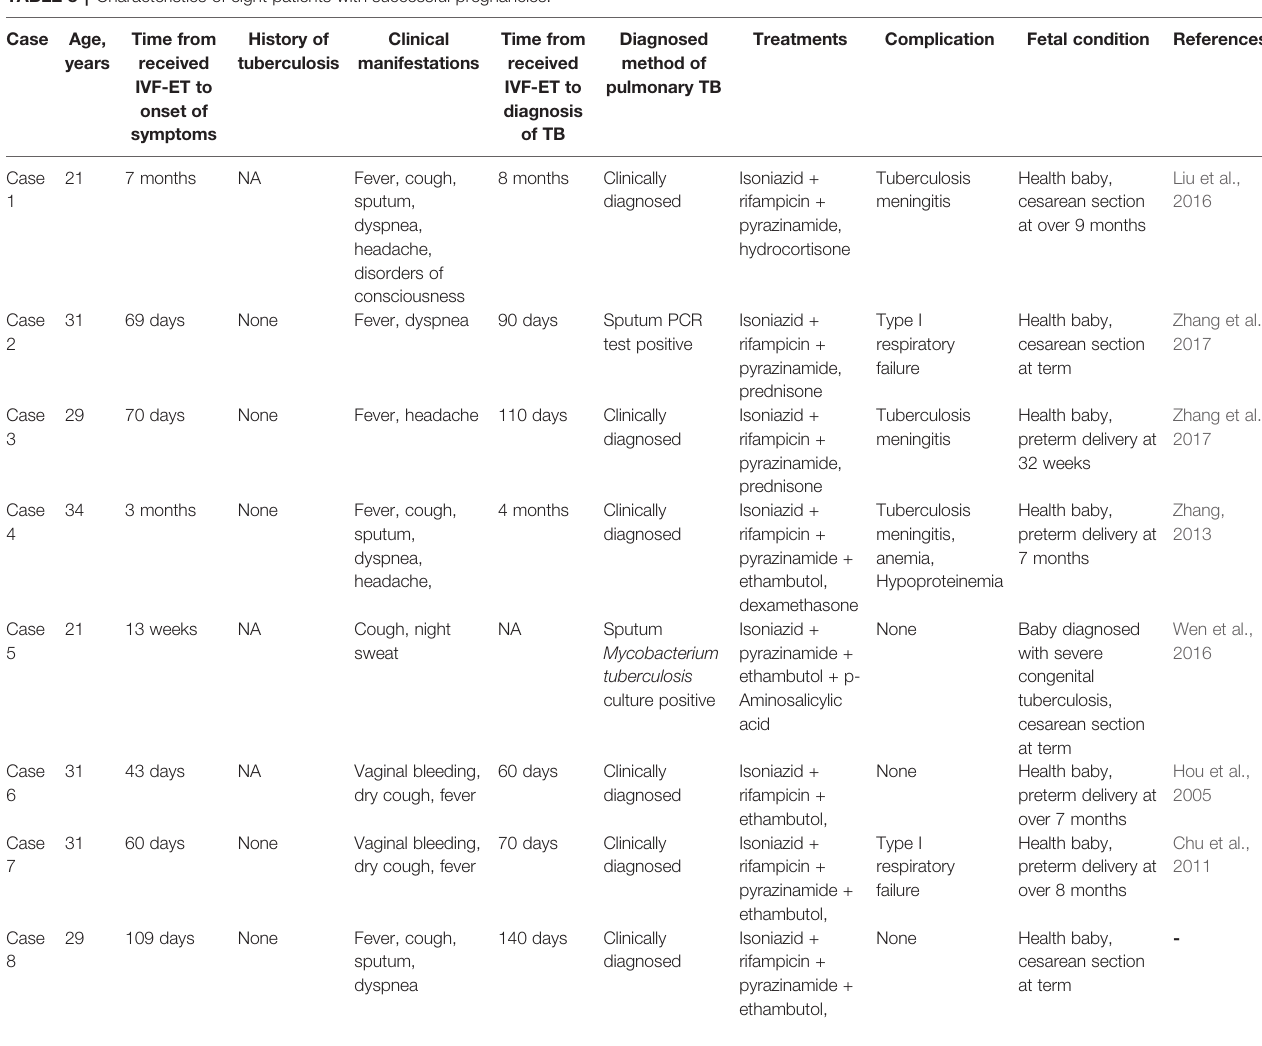
TABLE 8 | Characteristics of eight patients with successful pregnancies.